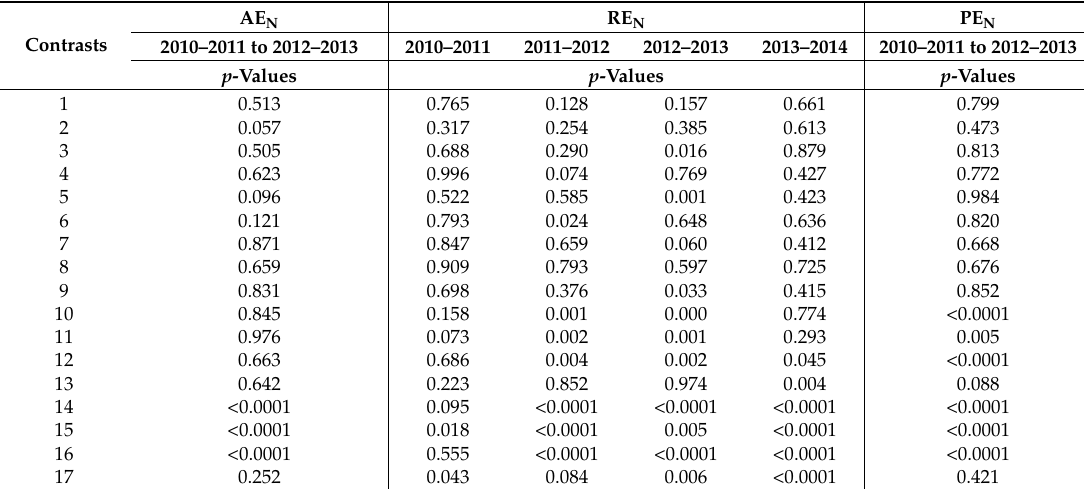
Table 7. p values of contrasts on nitrogen (N) agronomic efficiency (AE N ), crop recovery efficiency of applied N (RE N ), and physiological efficiency of applied N (PE N ), as influenced by selected treatments composed of urea sources, timing and method of fertilizer application at the International Maize and Wheat Improvement Center (CIMMYT), in the Yaqui valley, near Ciudad Obregon, Sonora, Mexico. AE N RE N PE N Contrasts p -Values p -Values p -Values